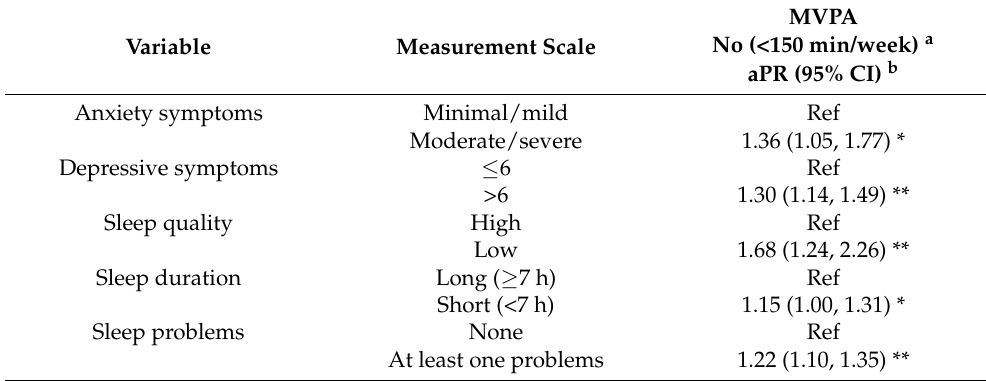
Table 2. Poisson regression models to demonstrate the associations between moderate-to-vigorous physical activity (MVPA) and mental and sleep health outcomes (N =